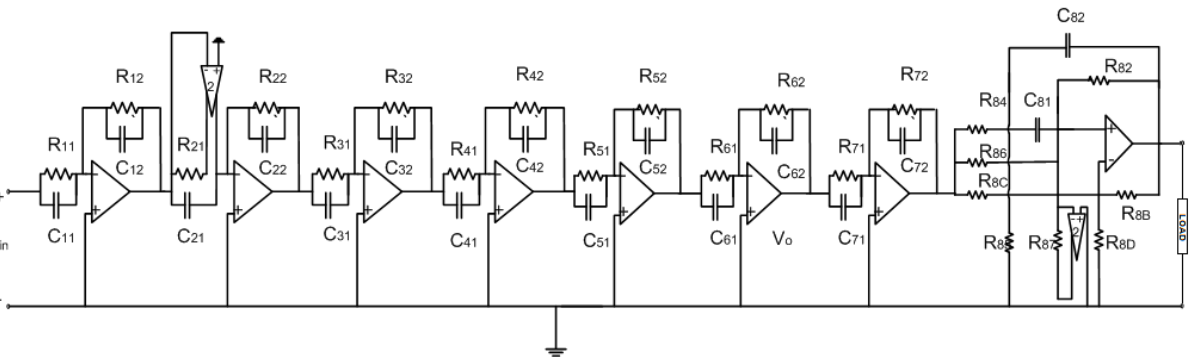
Figure 7. The circuit that produces the ESD current at +4